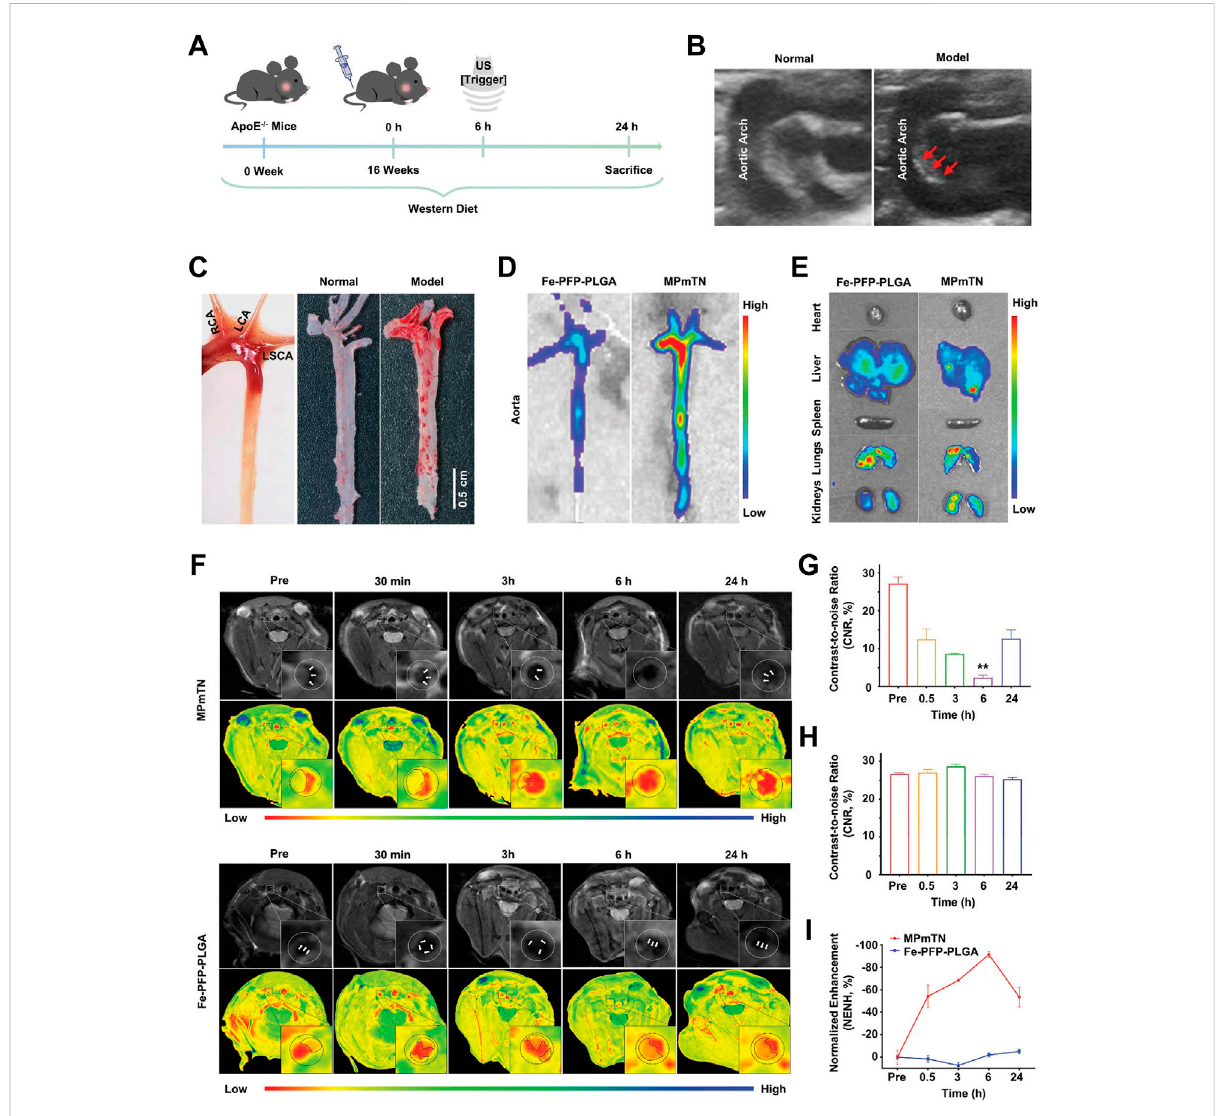
FIGURE 13 Targeting and MR imaging ability of IPMT-NP in vivo . (A) Schematic diagram showing the time scale of the in vivo animal experiment. (B) US images monitored atherosclerotic plaques in the aortic arch of model apoE − / − mice (right, red arrowhead) by comparing with age-matched normal mice (left). (C) Gross aortic vessel isolated from age-matched mice (left), representative photographs of Oil Red O-stained aorta form the control group (middle) and the ApoE − / − mice after a 16-week western diet (right). (D) Fluorescence images of aorta and (E) the extracted organs from miceat6 hposttheinjectionofDio-labeledFe-PFP-PLGANPsorMPmTNs. (F) T 2 -weightedandpseudo-colorimages, (G,H) CNR,and (I) %NENHof aorticplaquesatdifferentpointsaftertheinjectionofMPmTNsortheFe-PFP-PLGANPs(** p < 0.01)(CopyrightpermissionfromtheRoyalSocietyof Chemistry) (Gao et al.,